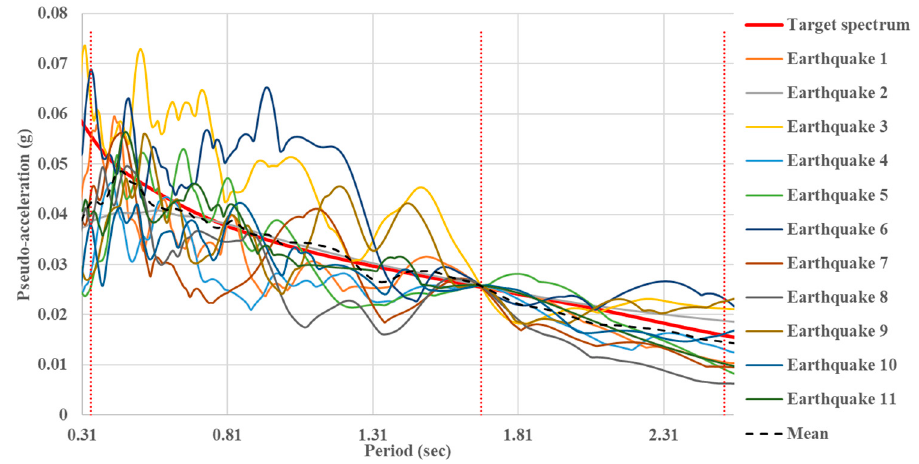
Figure 5. Ground motion selection for Agua Prieta, Sonora, corresponding to a return period of 72 years with respect to the reinforced concrete building.